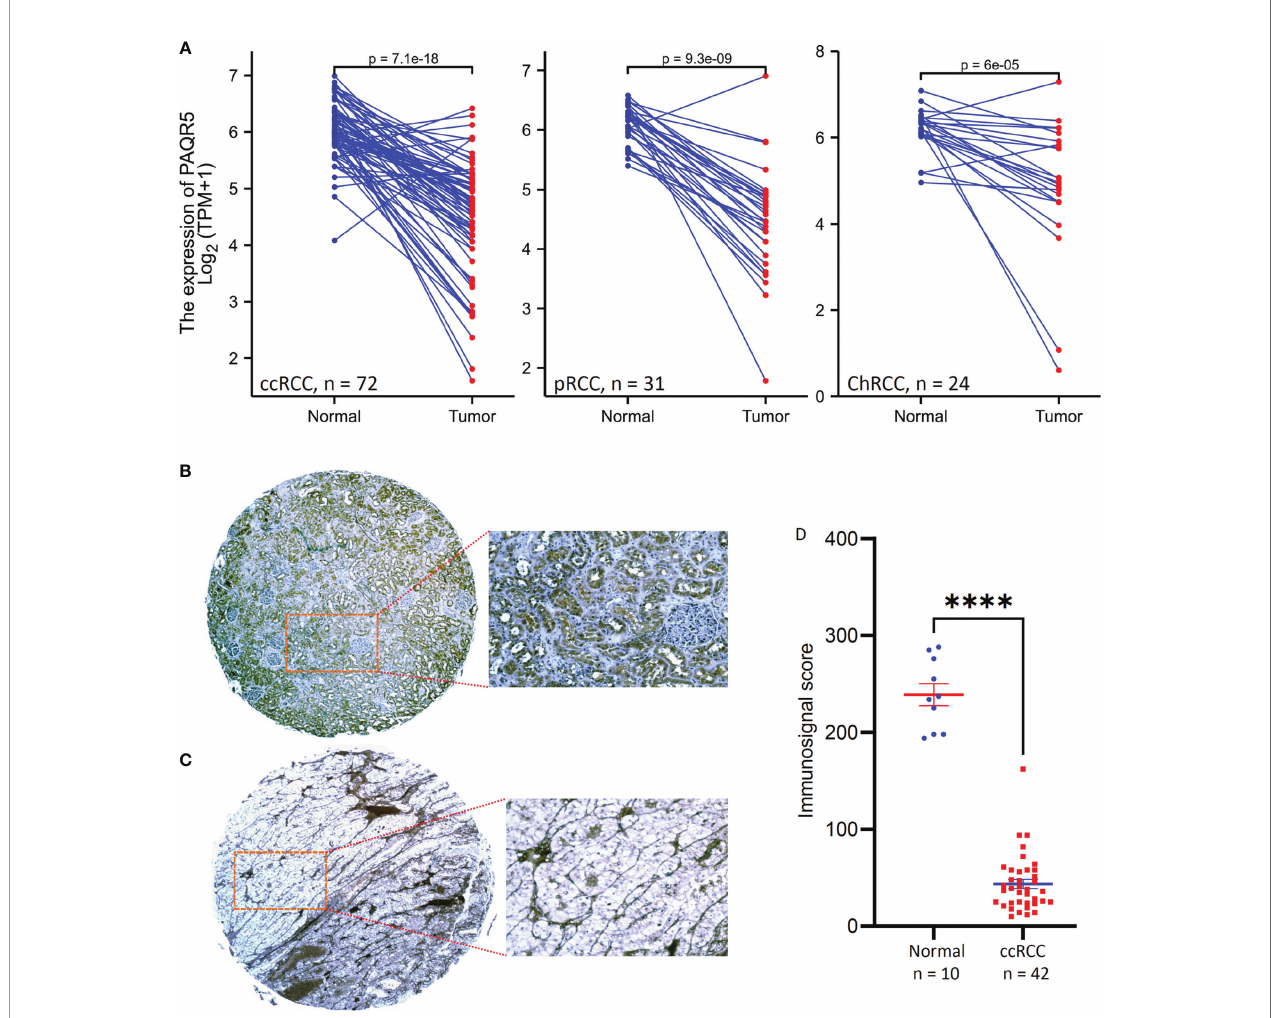
FIGURE 1 | PAQR5 expression in RCC tissues. (A) Pair-wise comparison was conducted using the RNA-seq datasets from the TCGA project. The p-values were derived from Wilcoxon signed-rank test. (B, C) Representative microscopic images were taken from anti-PAQR5 immunohistochemistry on the normal kidney (B) and ccRCC tissue (C) sections. Magni fi cation x 200. (D) Semi-quantitative data from immunohistochemistry staining were compared between normal kidney and ccRCC tissues. The error bars indicate the MEAN and SEM. The Quadro asterisk indicates a signi fi cant difference (Student t -test, p <